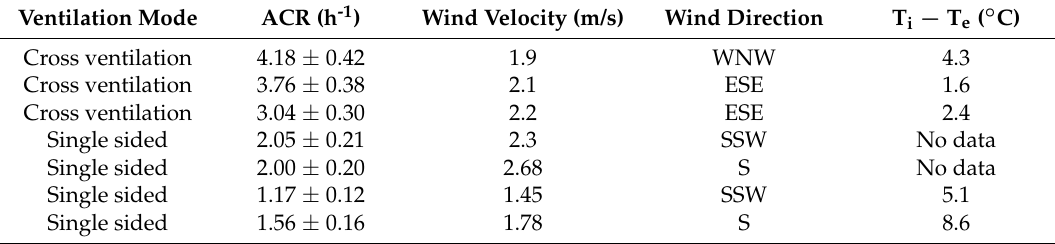
Table 4. Measured air changes rates (ACR) with tracer gas decay during spring